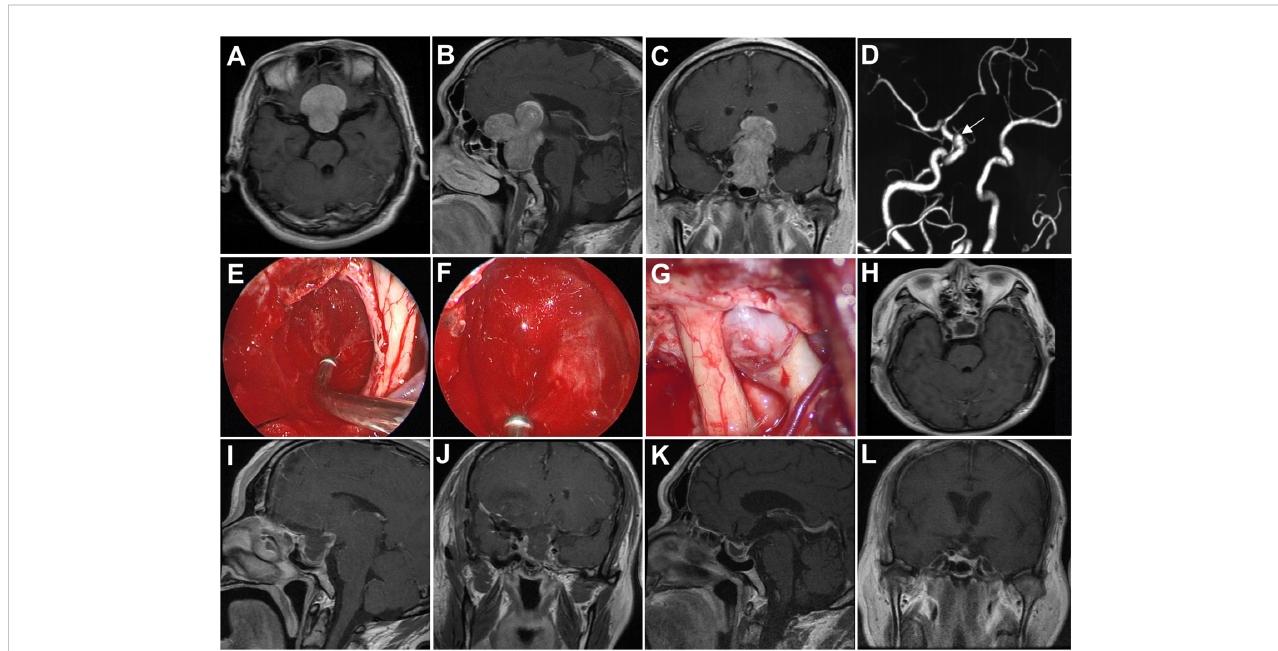
FIGURE 2 Case 1. Pre- and postoperative imaging fi ndings and intraoperative images. (A – C) Preoperative axial (A) , sagittal (B) and coronal (C) gadolinium-enhanced T1-weighted MRI images showing a giant pituitary adenoma with extensive suprasellar extension. (D) Preoperative CTA examination reveals an aneurysm located in the C6 segment of the right internal carotid artery. The white arrow indicates the aneurysm. (E) Intraoperative photograph showing that the tumor in the intrasellar part is removed with angled suctions under endoscopic view. (F) Intraoperative endoscopic photograph showing the fi nal view after removal of the intrasellar tumor. (G) Intraoperative microscopic photograph showing the aneurysm. (H – J) Postoperative axial (H) , sagittal (I) and coronal (J) gadolinium-enhanced T1-weighted MRI images showing gross total resection of the pituitary tumor two days after surgery. (K, L) Postoperative sagittal (K) and coronal (L) gadolinium-enhanced T1-weighted MRI images obtained 4 months after